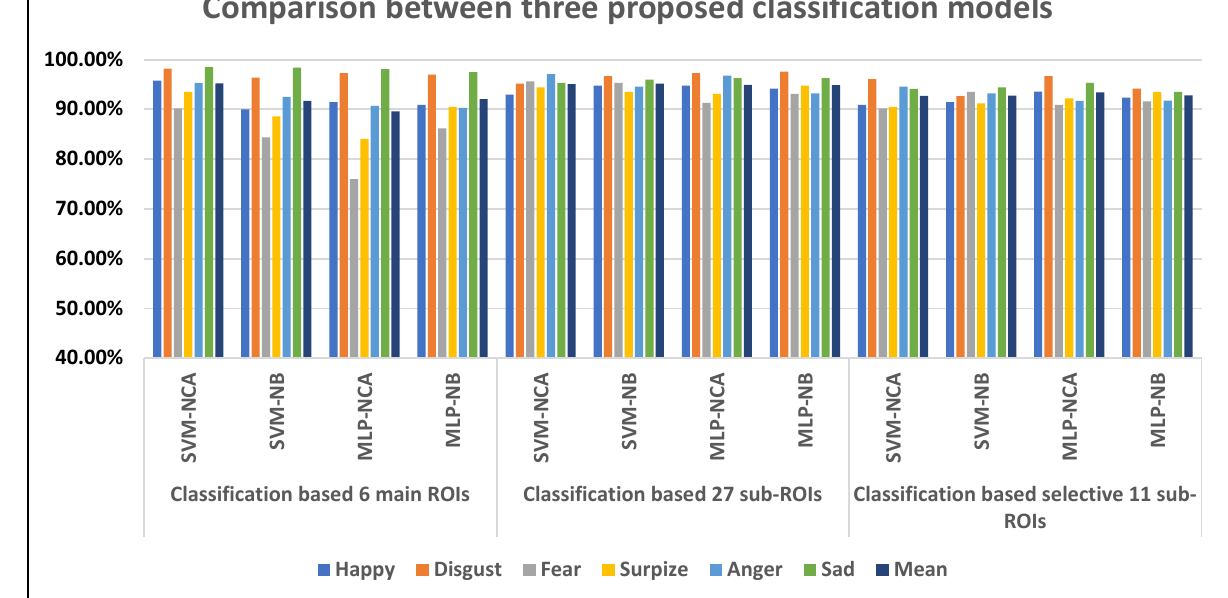
Figure 5. Comparison between three proposed classification models. Table 7. Comparative results with other literature studies based on USTC-NVIE